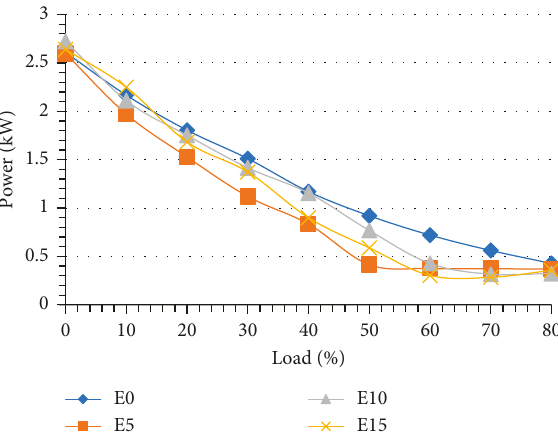
Figure 9: The effect of ethanol on engine